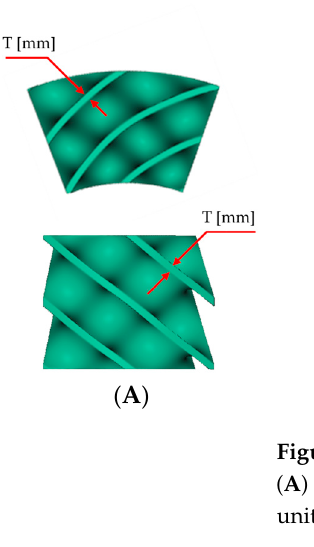
Figure 2. Project of Diamond TPMS cylindrical structures on example Diamond_9_1_0.64 structure: ( A ) unit cell (top and side view); ( B ) geometrical dimensions (top and side view; green color- single unit cell; orange color- single layer of unit cells).